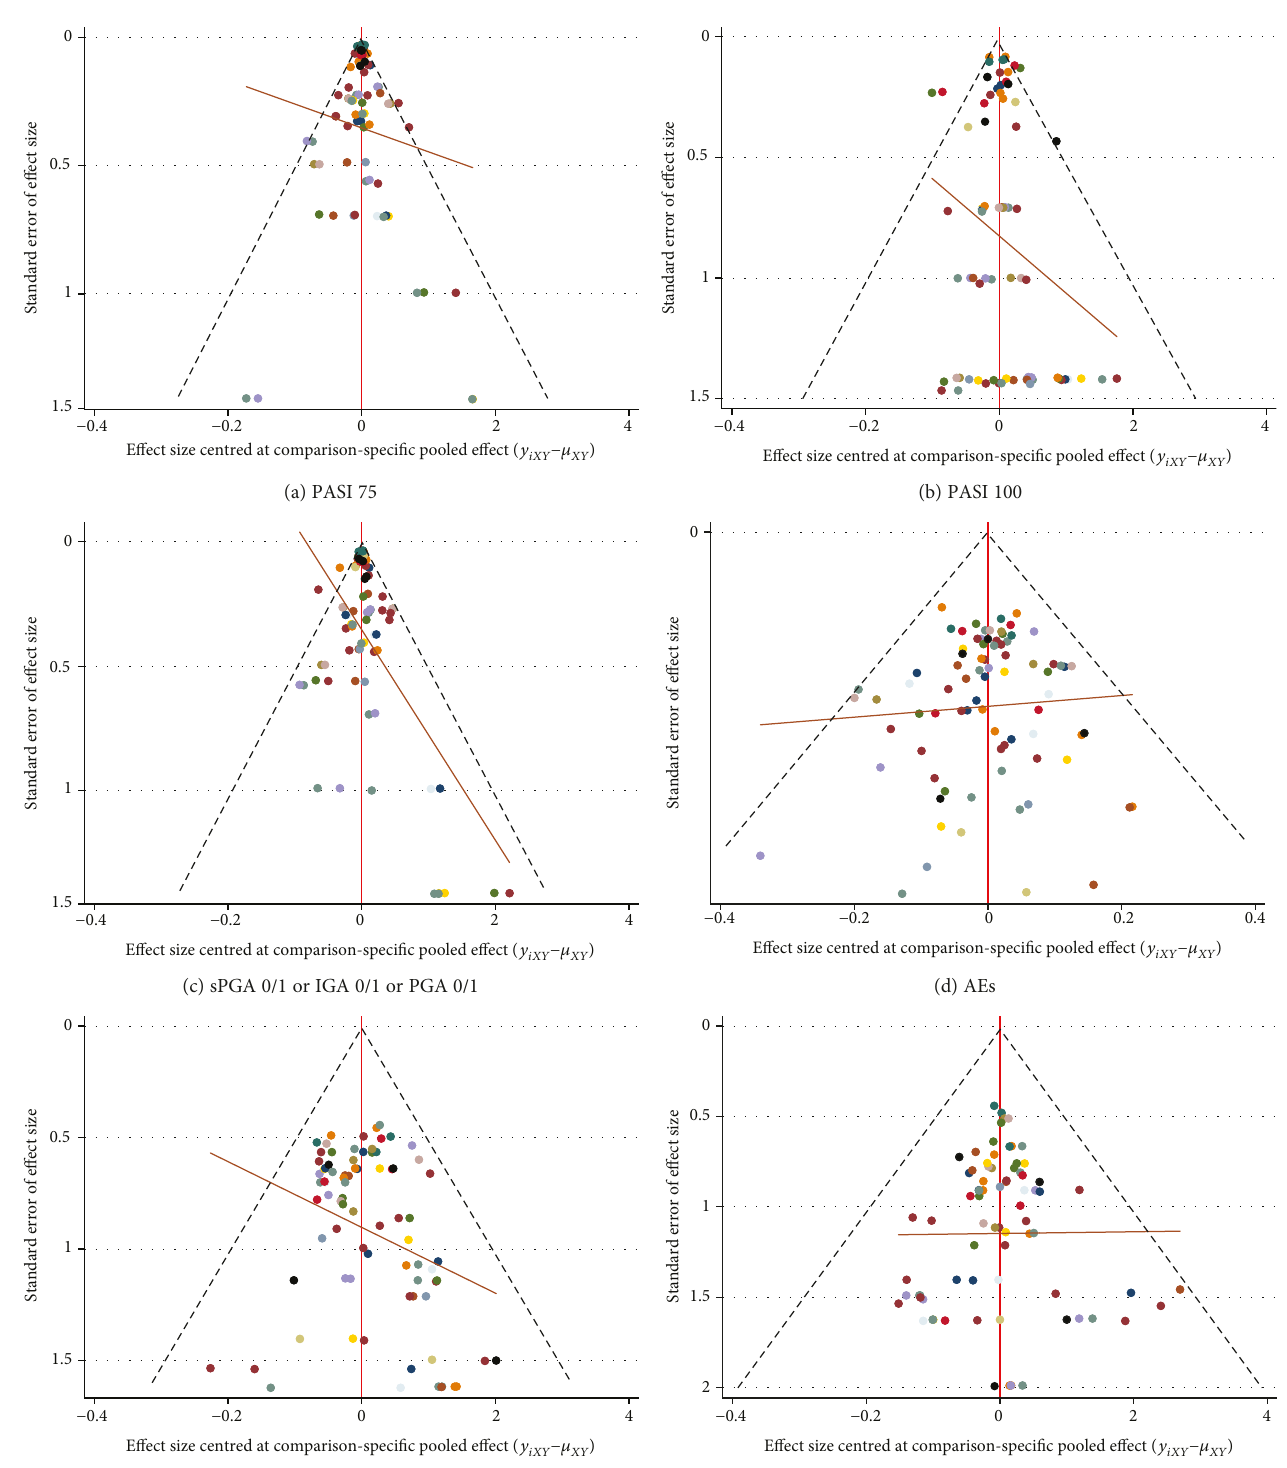
Figure 12: Comparison-adjusted funnel plots of all the outcomes in network meta-analysis. PASI 75: the percentages of patients with a 75% improvement from baseline in the PASI score; PASI 100: the percentages of patients with a 100% improvement from baseline in the PASI score; sPGA 0/1: static physician ’ s global assessment score of 0 or 1; IGA 0/1: a response of 0 or 1 on the modi fi ed investigator ’ s